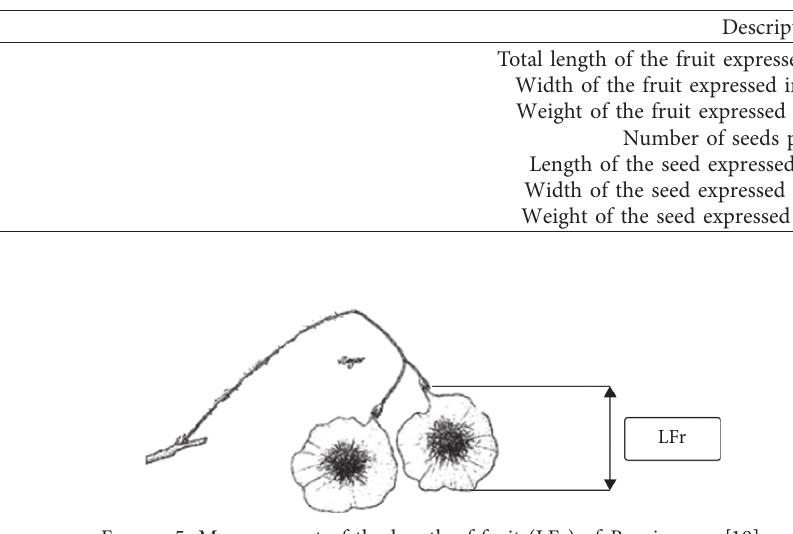
Table 4: Propagule descriptors.